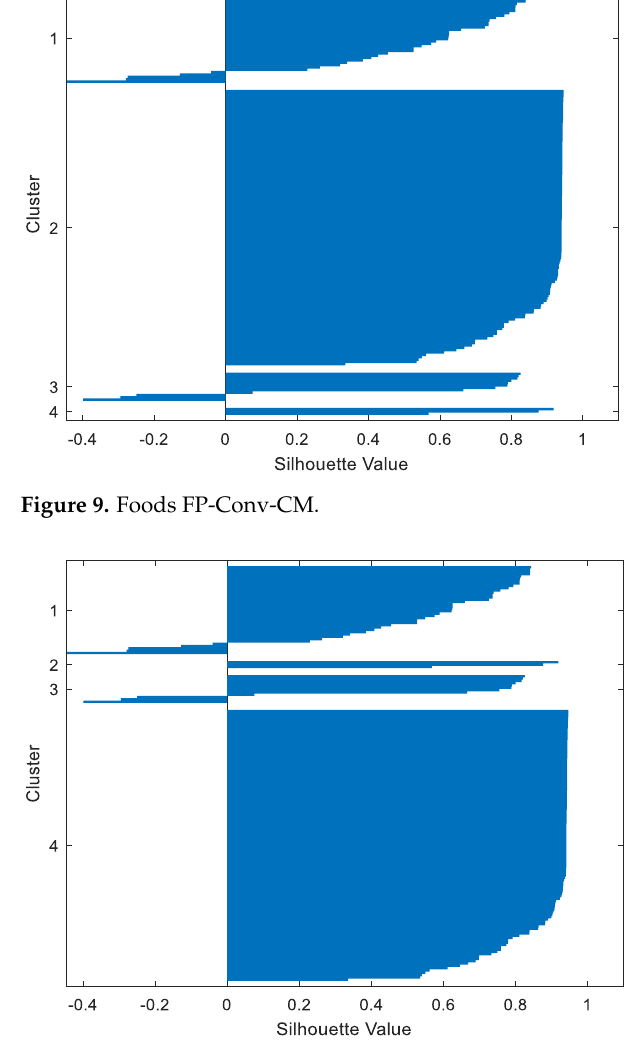
Figure 10. Foods FCM.